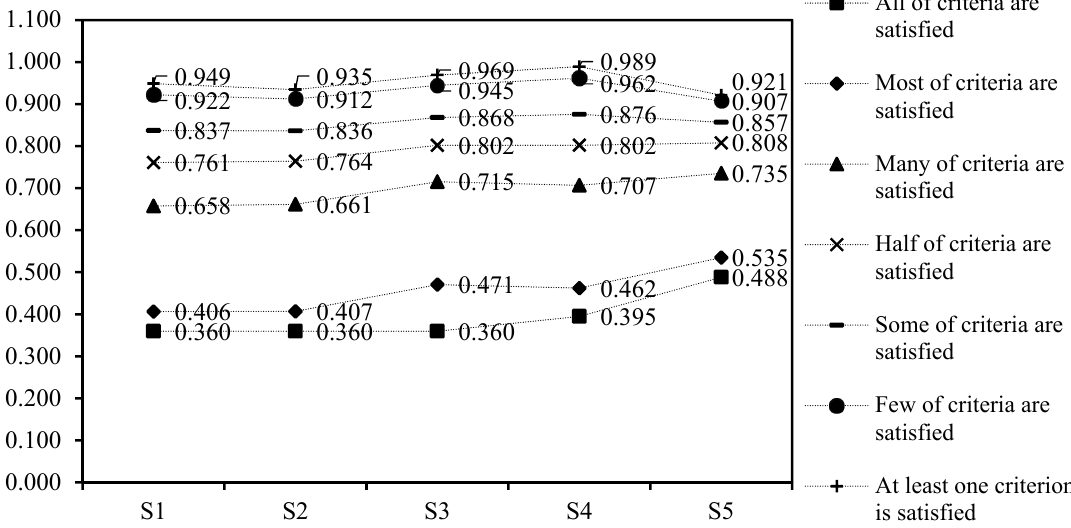
Figure 13. The internal modified ordered weighted averaging (IMOWA) scores of the Kashafroud water strategies in each group viewpoint for the risk cases.